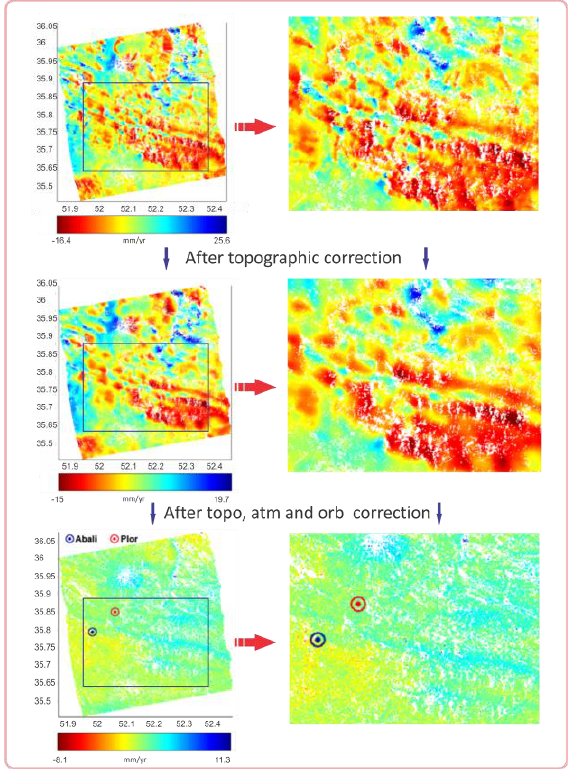
Figure 8: a) Velocity map calculated by ALOS dataset